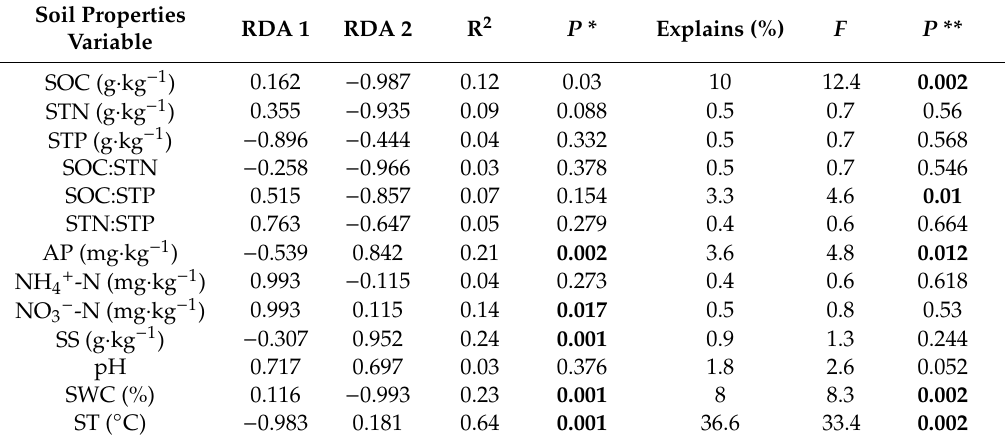
Figure 2. Redundancy analysis (RDA) ordination for leaf stoichiometry of P. australis and soil environmental factors. SOC, soil organic carbon; STN, soil total nitrogen; STP, soil total phosphorus; AP, soil available phosphorus; NH 4 + -N, soil ammonium nitrogen; NO 3 − -N, soil nitrate nitrogen; SWC, soil water content; ST, soil temperature; SS, soil salt; LC, leaf carbon concentration; LN, leaf nitrogen concentration; LP, leaf phosphorus concentration. Table 2. The explained variance of soil properties variable and their significant analysis in the first two axes in redundancy analysis (RDA)